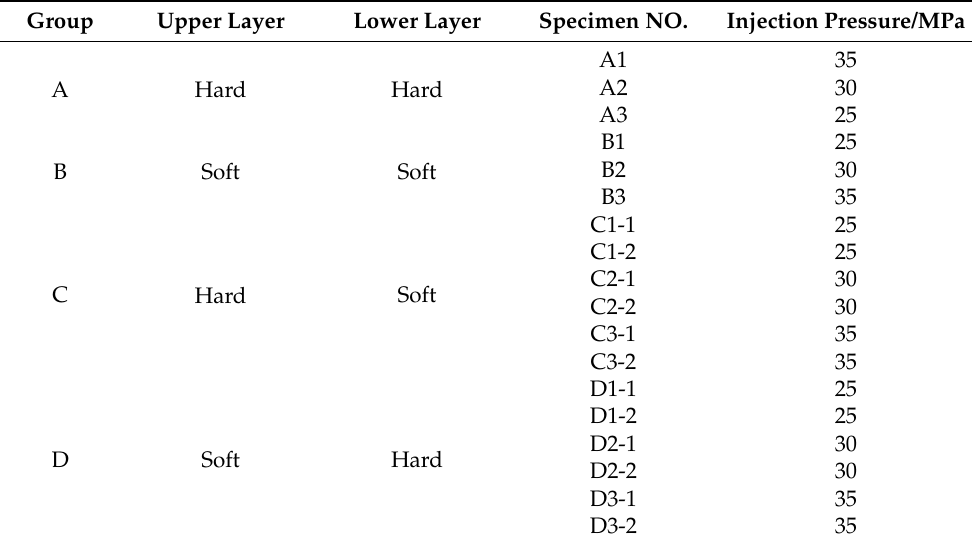
Table 3. The experimental parameters.